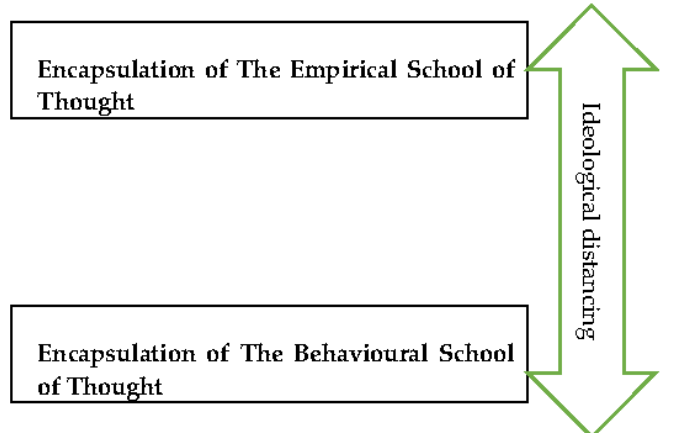
Figure 1. Visualisation of the parallel upbringings of cost overrun concepts and